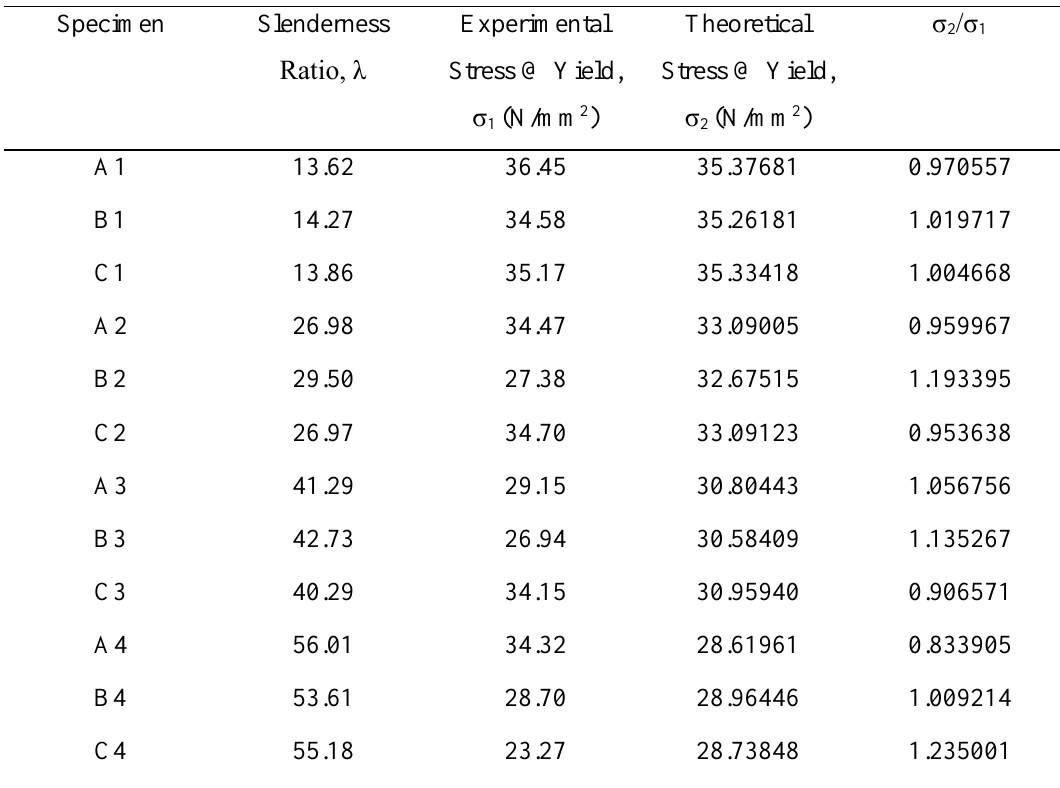
Theoretical Stress @ Yield and Slenderness Ratio for